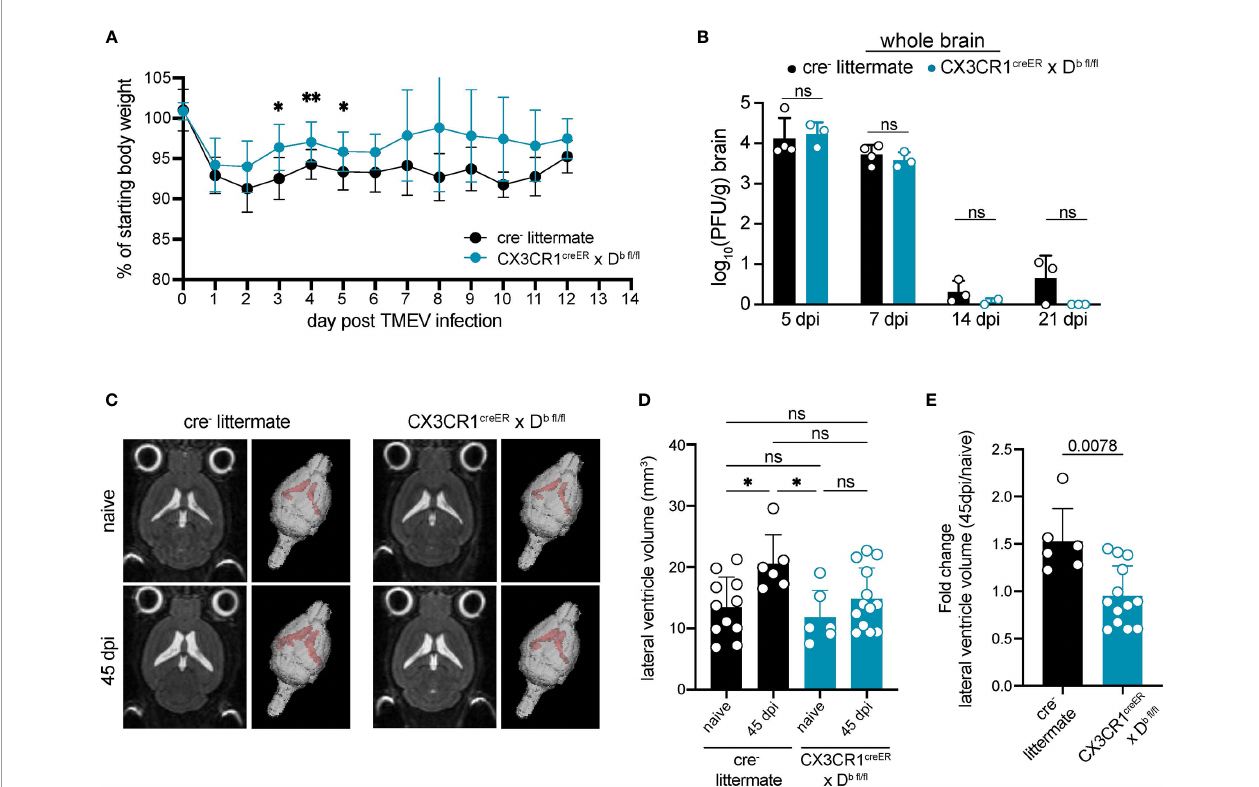
FIGURE 7 | H-2D b expression by CNS-myeloid cells impacts antiviral immunity and brain atrophy. Experimental strategy is identical to Figure 3E , in which tamoxifen administration in CX3CR1 cre /D b mice and cre - controls is followed by a 6-week reconstitution period before i.c. infection with TMEV. (A) Weight loss over the course of infection is measured in cre - and CX3CR1 cre /D b mice. (B) Infectious viral load in whole brain homogenates at 5-, 7-, 14-, and 21-days post infection is measured by plaque assay in cre - and CX3CR1 cre /D b mice. (C) Representative 2D images and 3D renderings of lateral ventricle volumes obtained by T2 weighted MRI of cre - and CX3CR1 cre /D b mice during naïve conditions and after recovery from TMEV infection (45 dpi). Images were analyzed using Analyze 12.0 (D) Lateral ventricle volume is quanti fi ed for naïve and TMEV-recovered cre - controls and CX3CR1 cre /D b mice. (E) Fold change in lateral ventricle volume from naïve to 45dpi is quanti fi ed for TMEV-recovered cre - controls and CX3CR1 cre /D b mice. Data are shown as individual mice with mean from one independent experiment (n=3-13) of ≥ 2 experimental replicates. Error bars represent standard deviation. Two tailed Welch ’ s t test or one-way ANOVA with Tukey ’ s correction were used to assess statistical signi fi cance with ns p ≥ 0.05. * denotes P < 0.05, ** denotes P <